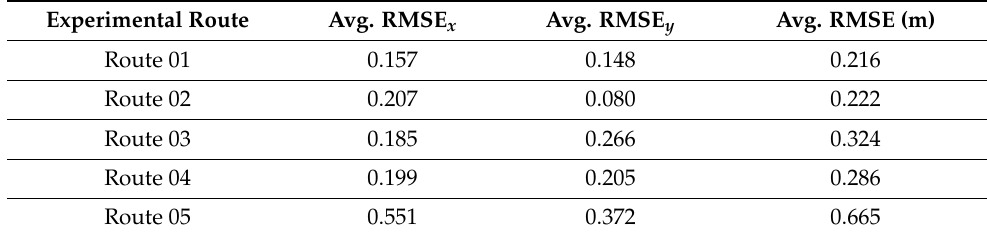
Table 4. Kalman Filter: The average RMSE of Routes 01~05.